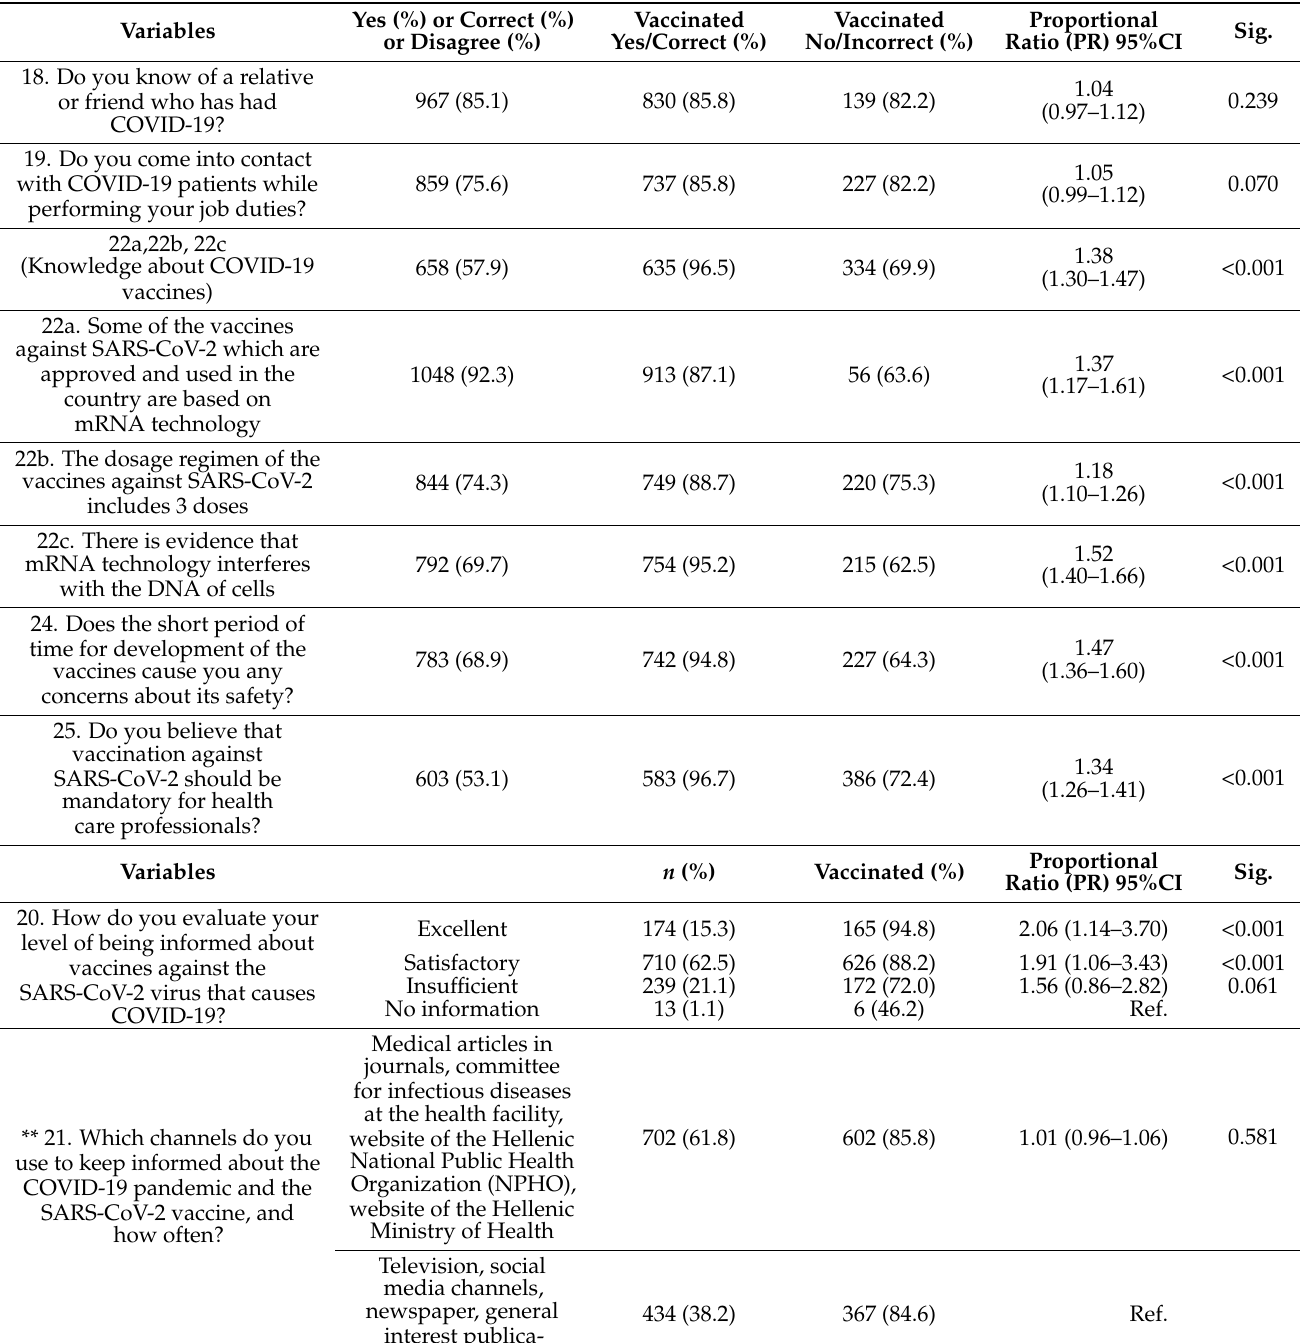
Table 3. Univariate analysis of the knowledge and attitudes towards COVID-19 vaccines and